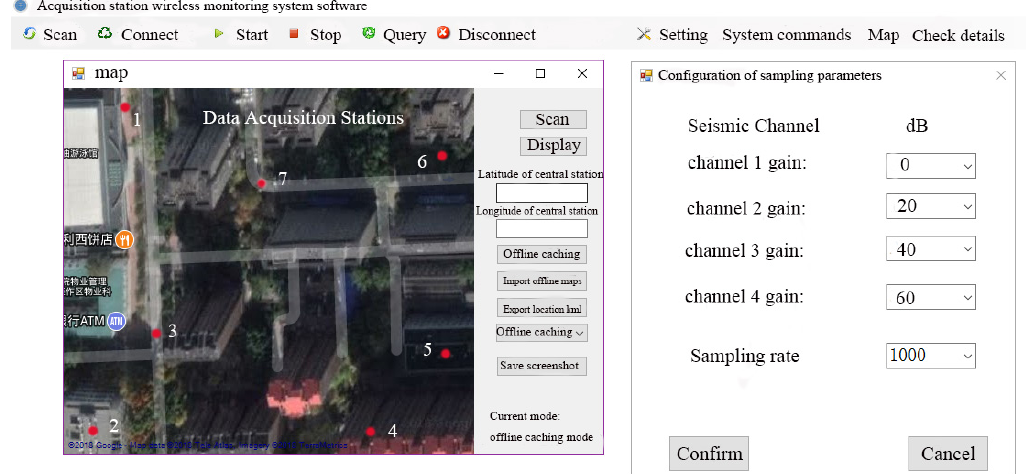
Figure 8. A part of the host software